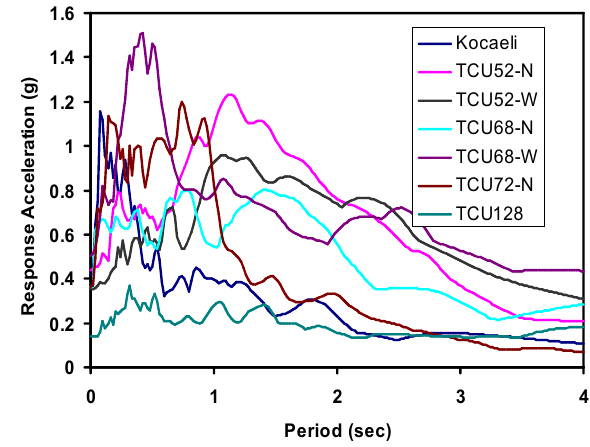
Figure 6. Elastic acceleration response spectra of far-fault ground motion recordings used in the Figure 7. Elastic acceleration response spectra of near-fault ground motion recordings used in the Fig. 6. Elastic acceleration response spectra of far-fault ground mo- Fig. 7. Elastic acceleration response spectra of near-fault ground tion recordings used in the evaluation of each building. evaluation of each building motion recordings used in the evaluation of each evaluation of each building